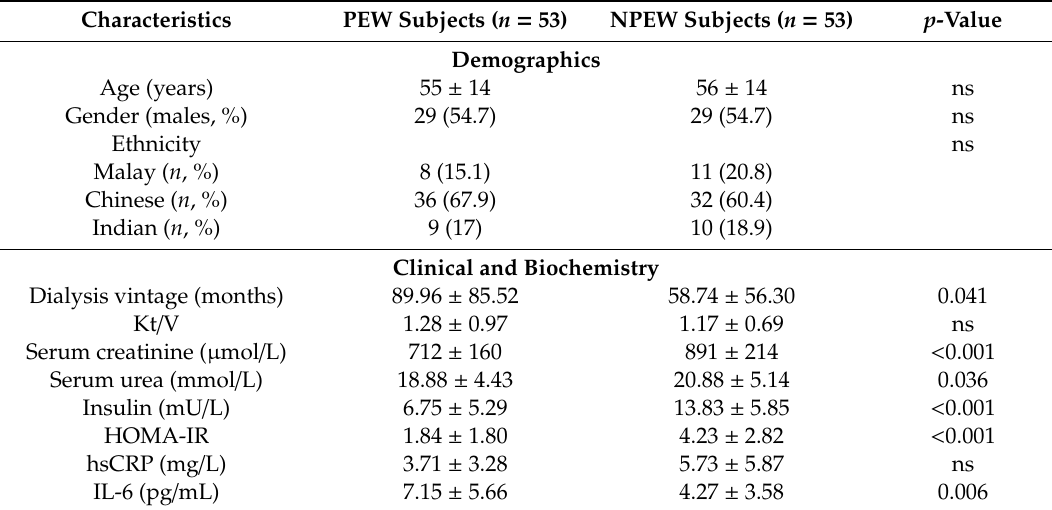
Table 1. Demographic, clinical and biochemical characteristics of the study